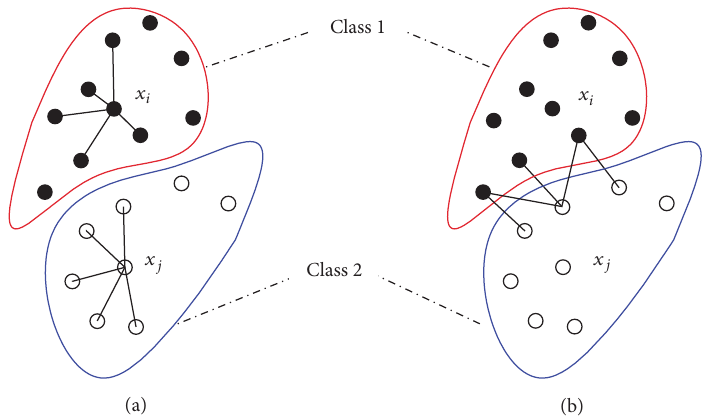
Figure 1: Neighborhood graphs: (a) intrinsic graph and (b) penalty